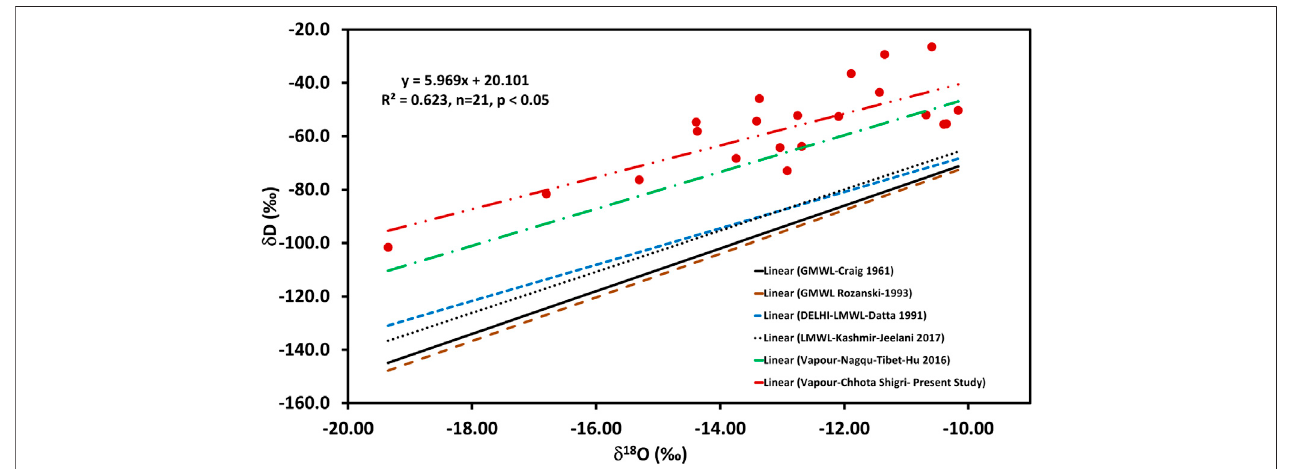
FIGURE 7 | Correlation between δ D and δ 18 O. It exhibits a slope of 5.96 ‰ / ‰ which is lower than the vapor at Nagqu, Tibet region (slope, 6.9). The positive intercept of 20.10 is, however, comparable (intercept, 23.2 ‰ ) to the Nagqu, Tibetan